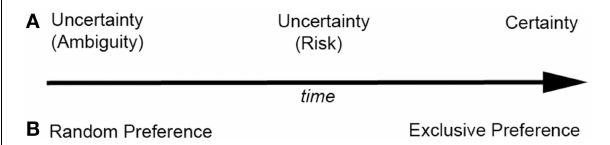
FIGURE 1 | Continuum representing the change in a participant’s (A) level of certainty and (B) preferences in a decision-making task as a function of